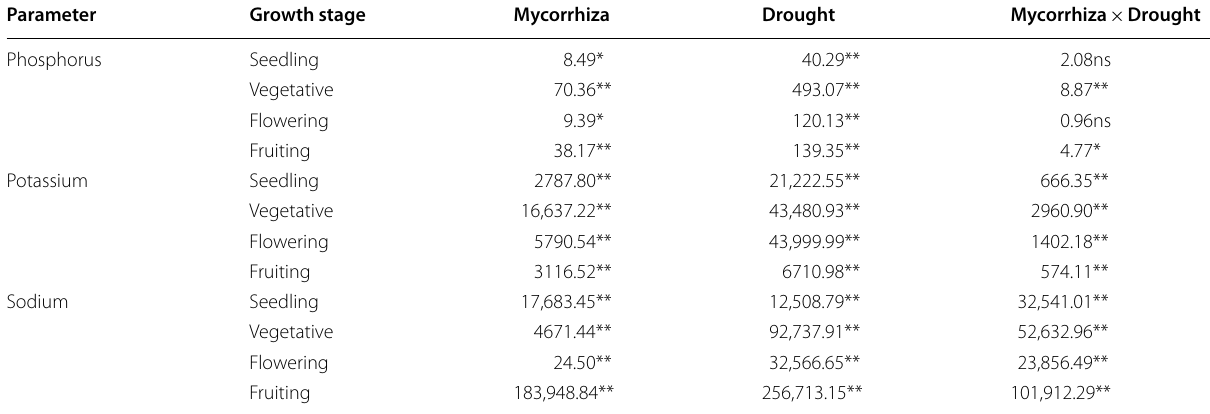
** P < 0.01; * P < 0.05; ns, non‑